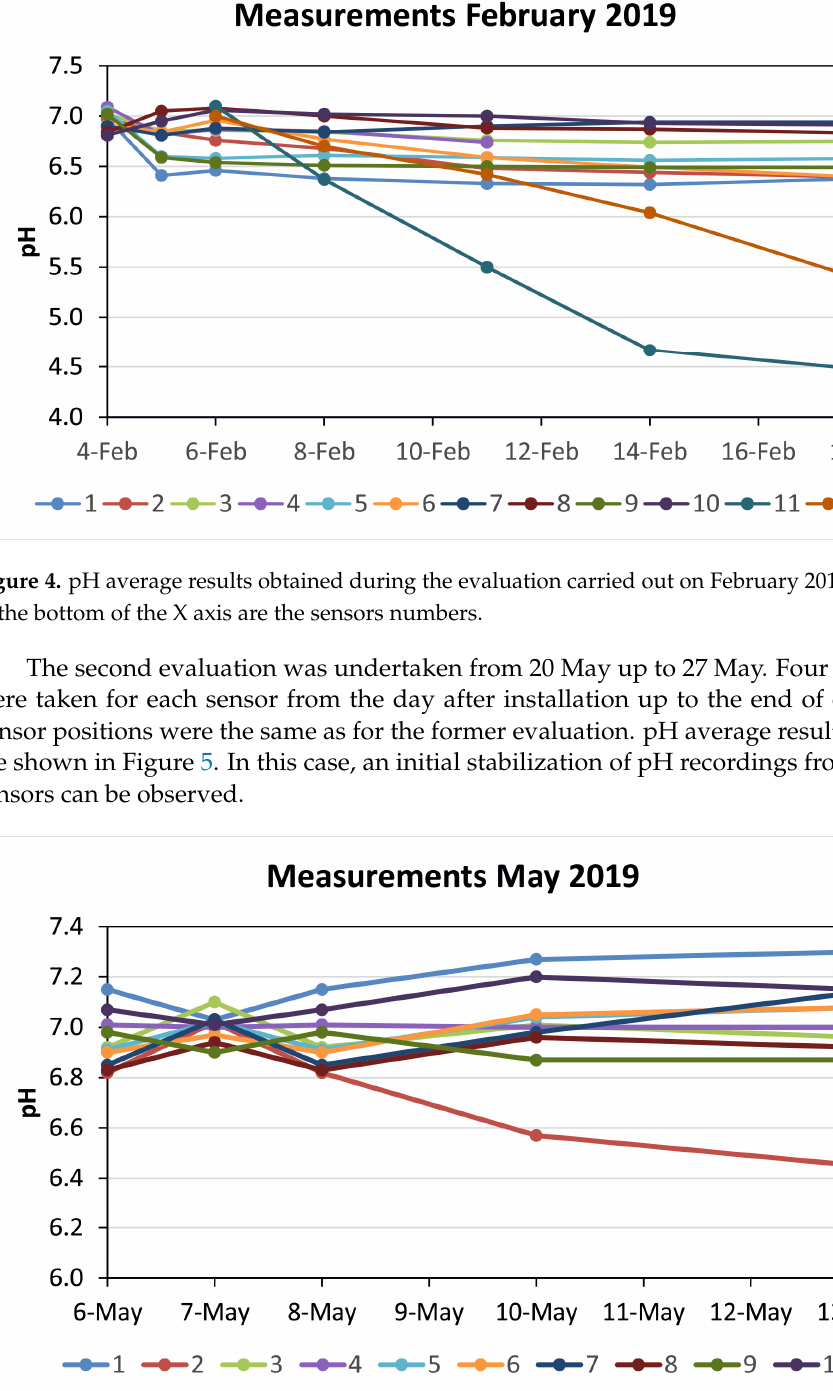
( c ) Figure 3. Some sensor positions. ( a ) Under the hall free environment. ( b ) Inside a showcase. ( c ) Outdoor in the main MNCN façade.